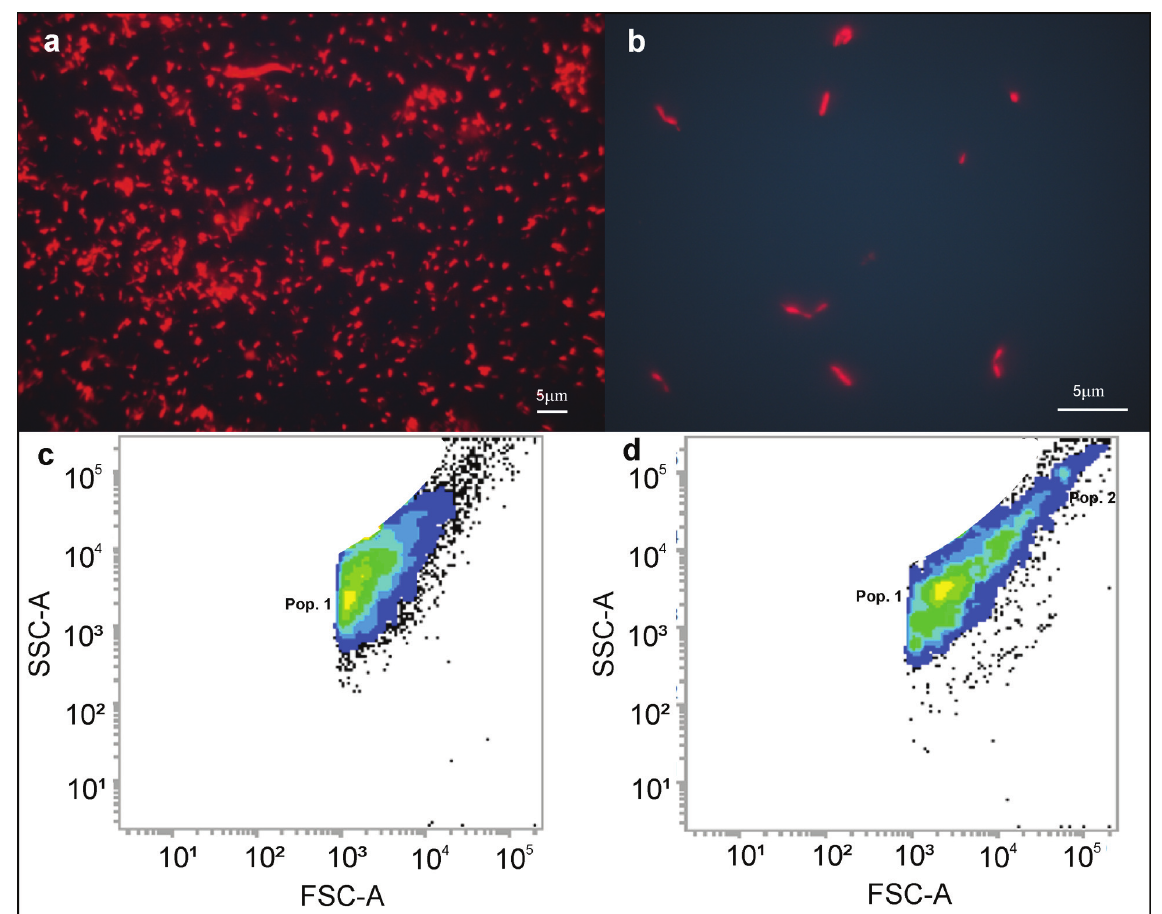
Figure 3 - Comparison of free-living bacterial communities between control (a) and T2 (b) with the evaluation of the population of bacteria by flow cytometer after 10,000 acquired events on control (c) and T2 (d). Lighter colours are related to higher density cells. For interpretation of the references to color in this figure legend, the reader is referred to the web version of this